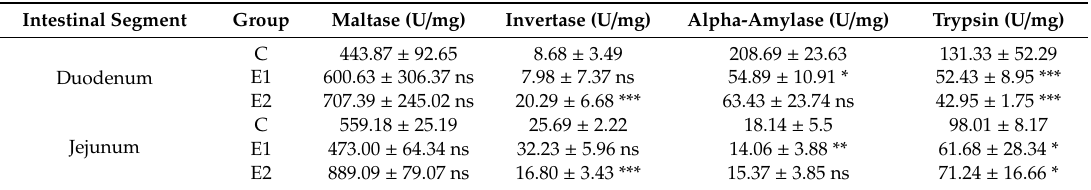
Table 4. Influence of dietary source on enzymatic specific activity (U / mg protein) of maltase, invertase, alpha-amylase, and trypsin of duodenum and jejunum of laying hens.